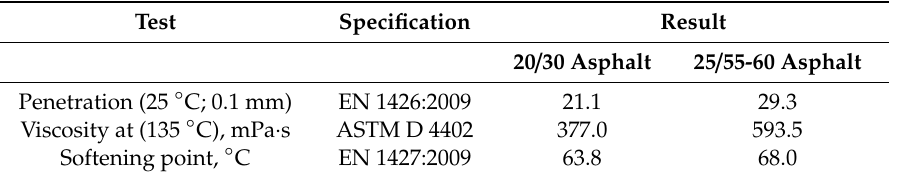
Table 1. Properties of the basic